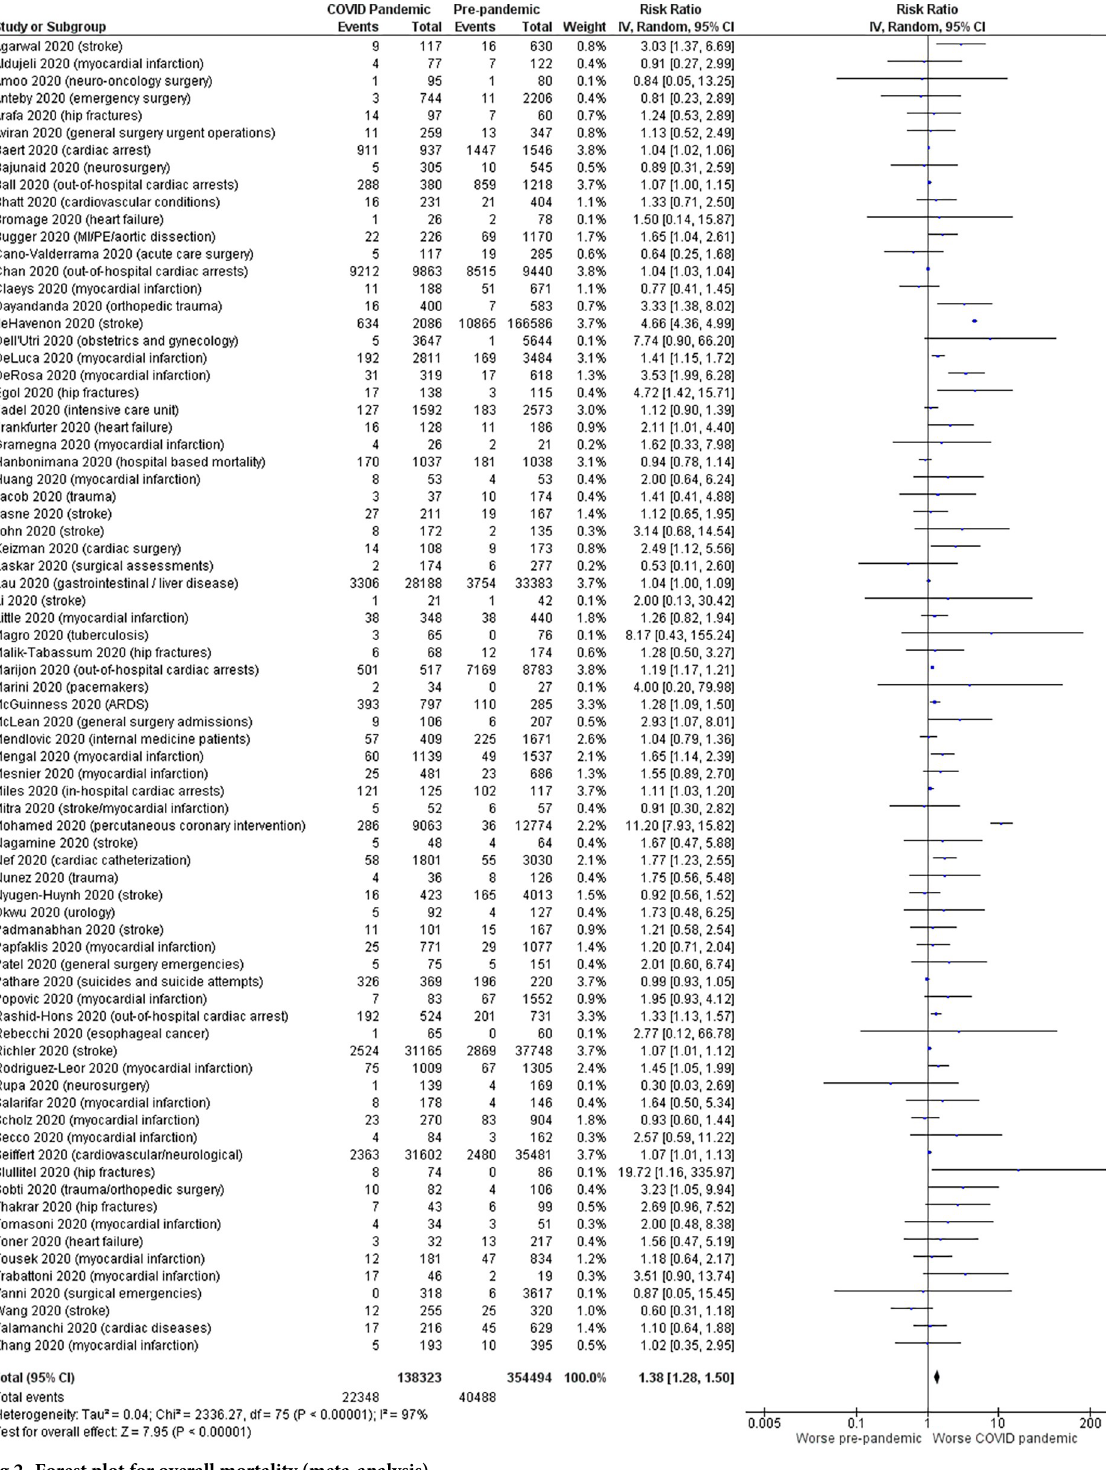
PLOS ONE | https://doi.org/10.1371/journal.pone.0269871 June 24,